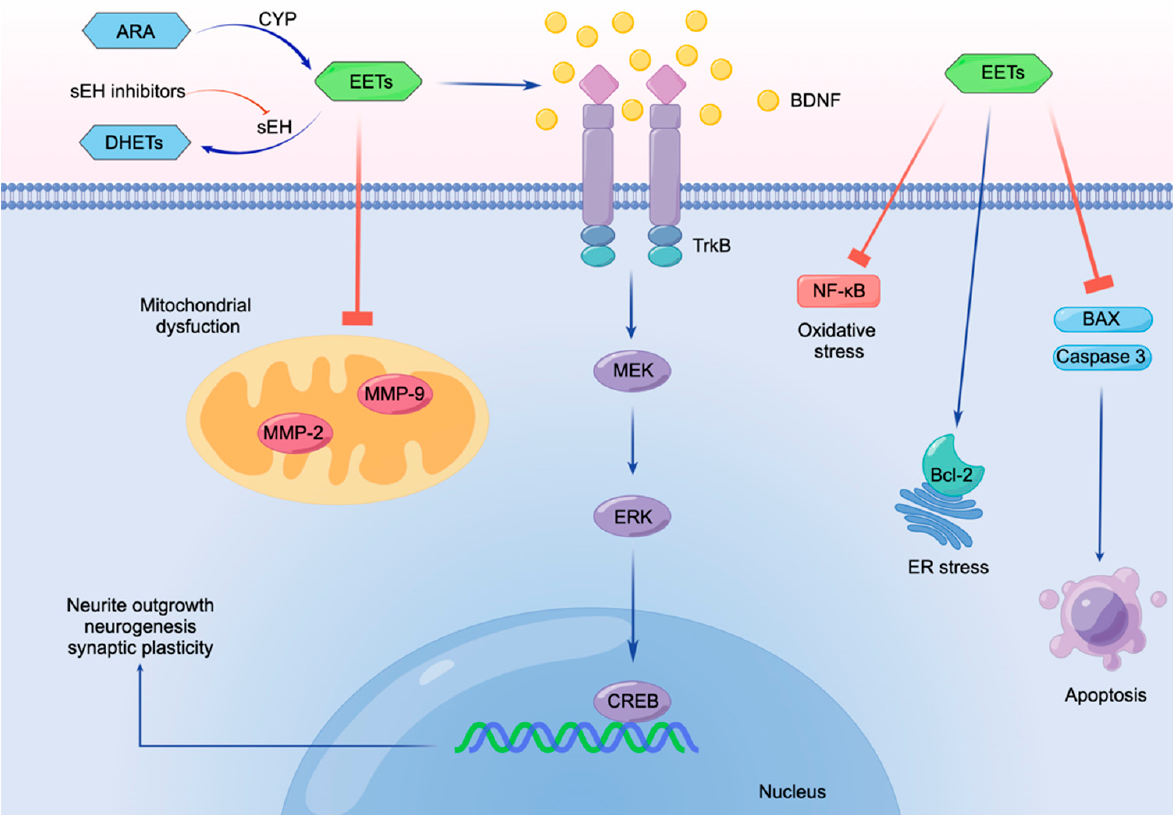
Figure 3. Molecular mechanisms underlying the neuroprotective effect of EETs. EETs suppress the MMP-2 and MMP-9 to prevent mitochondrial dysfunction. EETs induce the expression of BDNF, then stimulate BDNF-TrkB signaling. Subsequently, BDNF-TrkB signaling stimulates the MEK–ERK–CREB signaling pathway, promoting neurite outgrowth, neurogenesis, and synaptic plasticity. Furthermore, EETs reduce oxidative stress and suppress ER stress through suppression of NF-kB and activation of Bcl-2, respectively. Moreover, EETs protect against apoptosis through suppressing the BAX and Caspase-3; MMP-2: matrix metalloproteinase-2; MMP-9: matrix metalloproteinase-9; BDNF: brain derived neurotrophic factor; TrkB: tropomyosin receptor kinase B; MEK: mitogen-activated protein kinase; ERK: extracellular signal-regulated kinase; CREB: cAMP response element binding protein; ER: endoplasmic reticulum; NF- κ B: nuclear factor kappa-light-chain-en- hancer of activated B cells; Bcl-2: B-cell lymphoma 2; BAX: Bcl-2-associated X protein. Made by Fig- draw (www.figdraw.com).